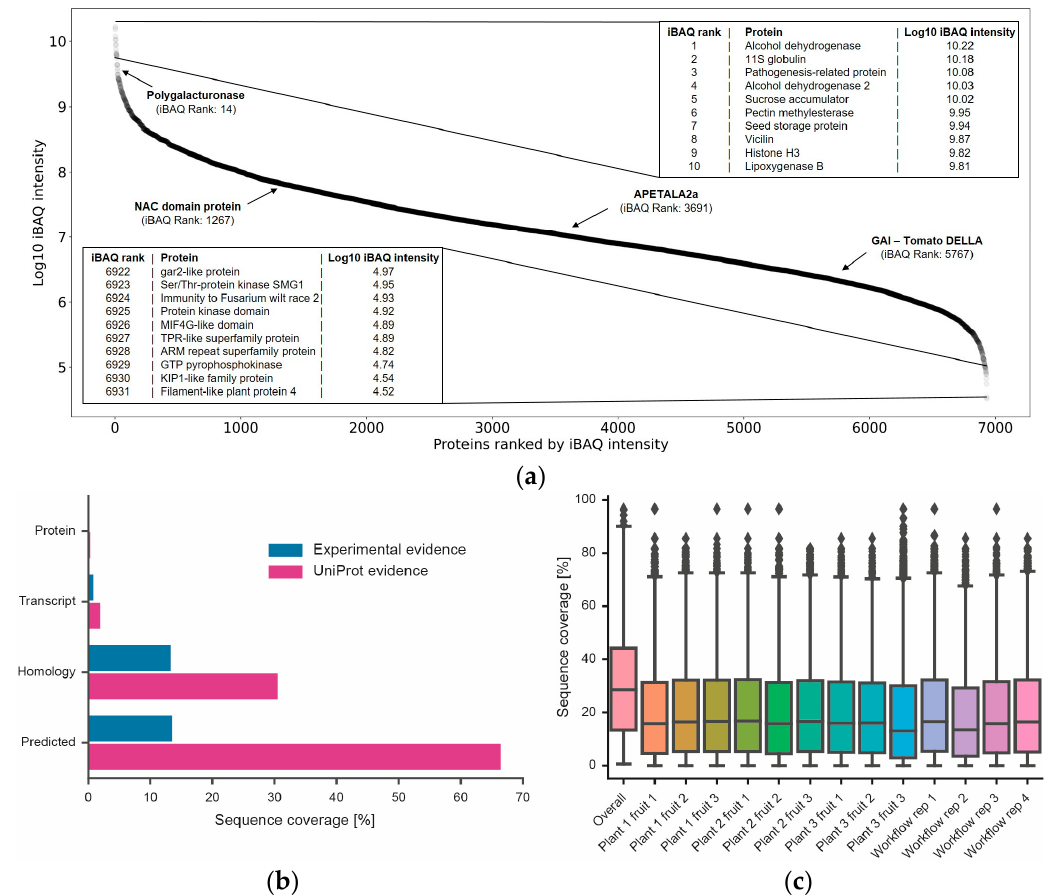
Figure 5. Dynamic range of proteome expression, discovery of new proteins and amino acid sequence coverage. ( a ) Ranked protein abundance plot and gene names of the 10 most highly expressed proteins and 10 least highly expressed proteins covered by the data. Four proteins important for tomato fruit development are also highlighted [38]. ( b ) Percentage of all tomato genes divided by difference evidence levels according to UniProt (orange). Blue bars represent proteins identified in this study. ( c ) Box plots showing the distribution of amino acid sequence coverage for proteins identified in each experiment or when combining all data into one analysis.